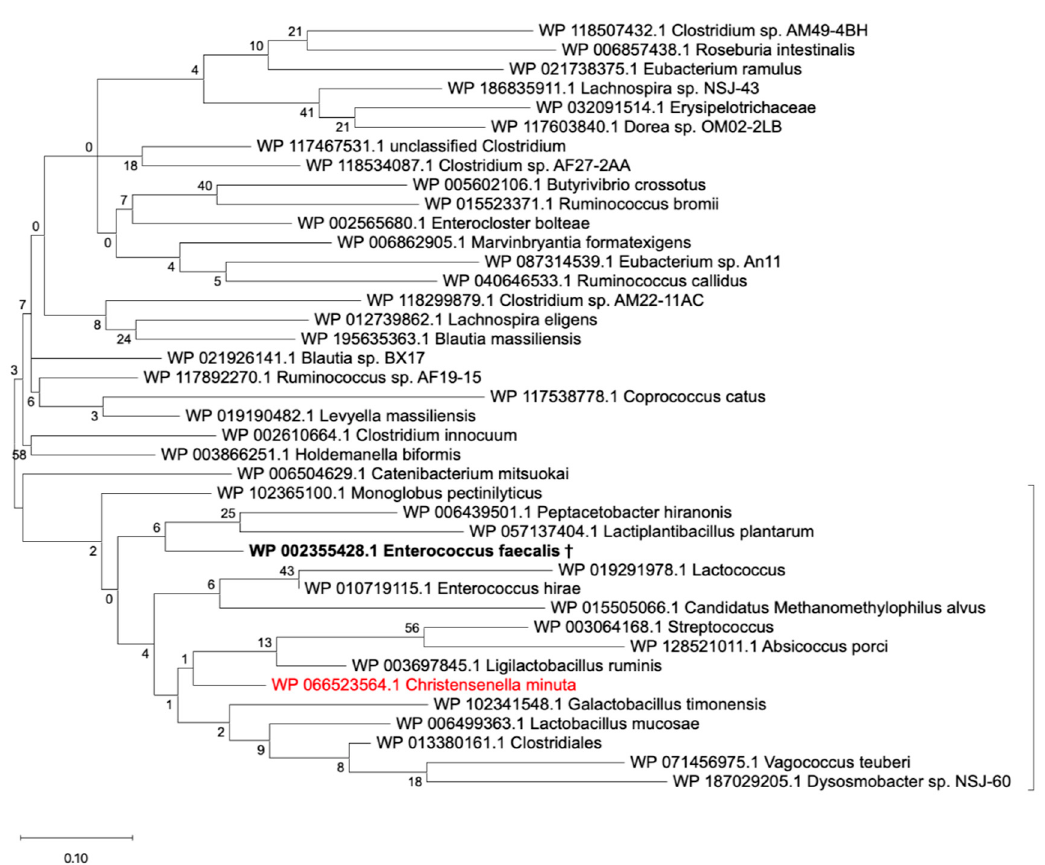
Figure 6. Phylogenetic tree of the BSH-C1 cluster. Bootstrap values are shown on each branch. The branch of the cluster containing the characterized BSH from Enterococcus faecalis is in bold (†: WP_002355428.1 with PDB structure 4WL3). The branch containing the C. minuta ’s BSH sequence is colored in red. The sequences from the clusters within the bracket were extracted and processed as mentioned in the Materials and Methods section to produce the phylogenetic tree shown in Figure S4.